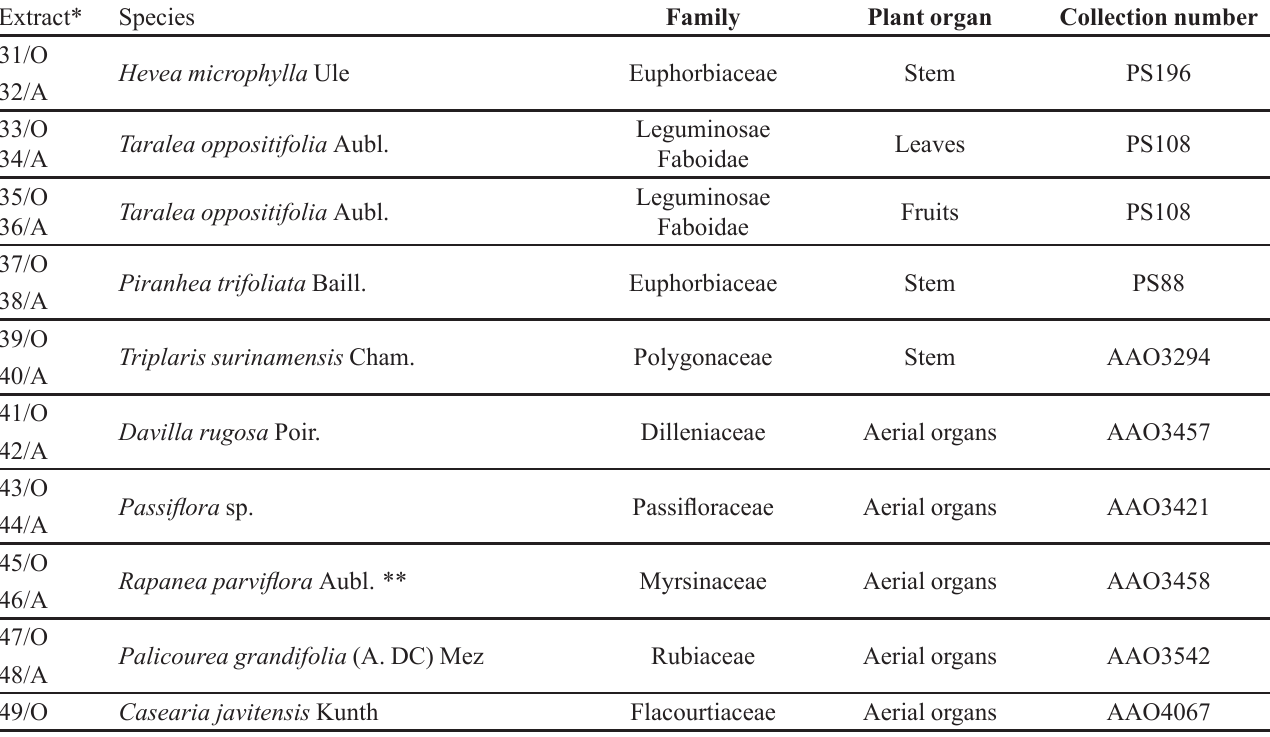
TABLE I - List of Amazonian Rain Forest plant extracts tested against tyrosinase